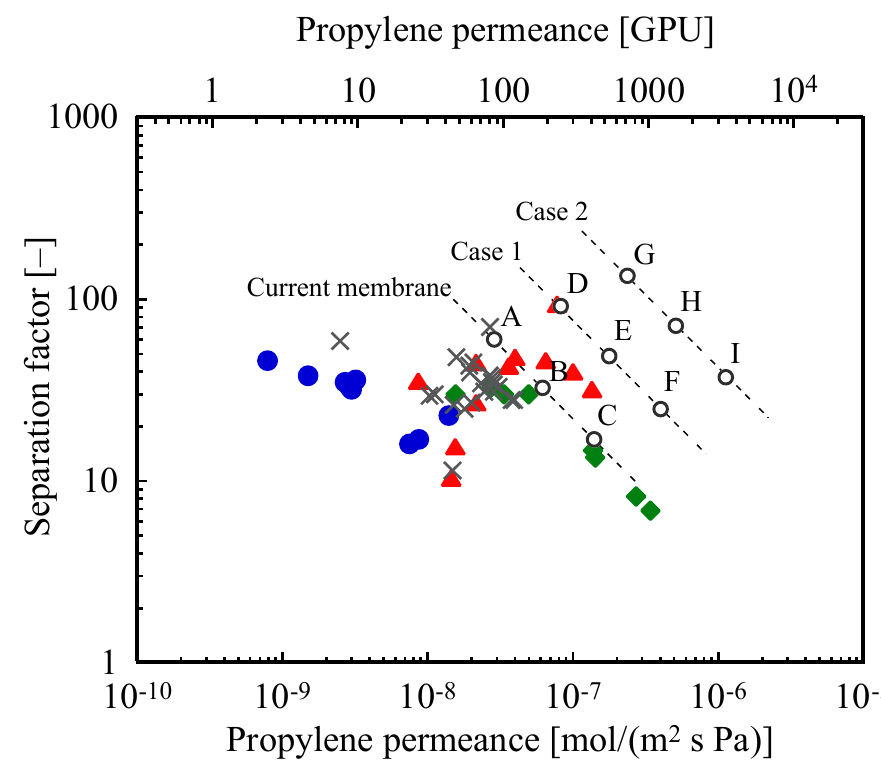
Figure 1. The relationship between propylene permeance and separation factor. O: membranes used in this study .